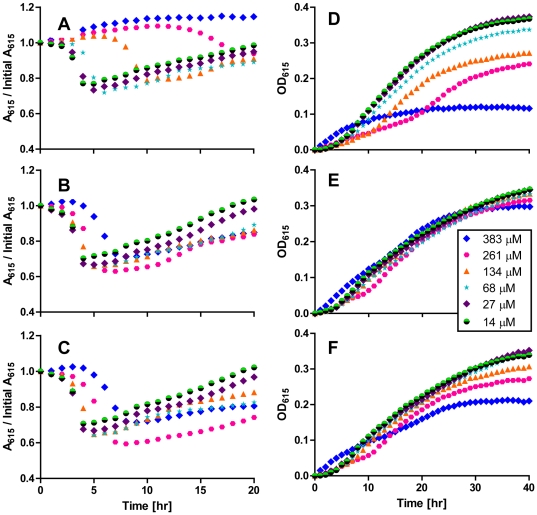
Impact of compounds 1, 2, and 3 on V. cholerae sugar fermentation and growth.The assays were carried out at 30°C in pH-MMSuc to monitor sugar fermentation by A615 (A, B, and C) or in MMPyr to monitor bacterial growth by OD615 (D, E, and F). Bacteria were exposed to mirandamycin (A and D), compound 2 (B and E) or compound 3 (C and F) at concentrations ranging from 14 to 383 µM. Replicate assay is shown in Figure S2.